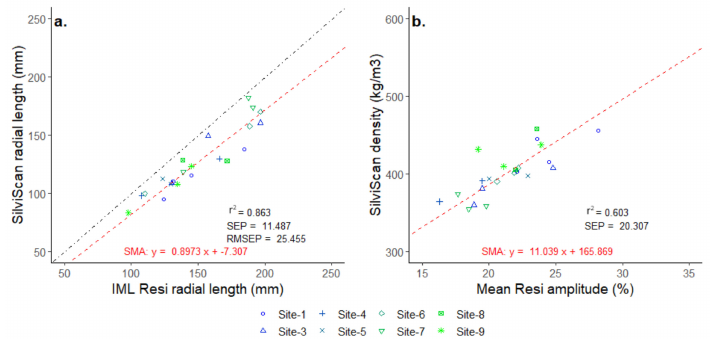
Figure 6. SilviScan sample length ( a ) and basic density ( b ) were strongly correlated with the pith-to- bark length and mean resistance determined from the Resi